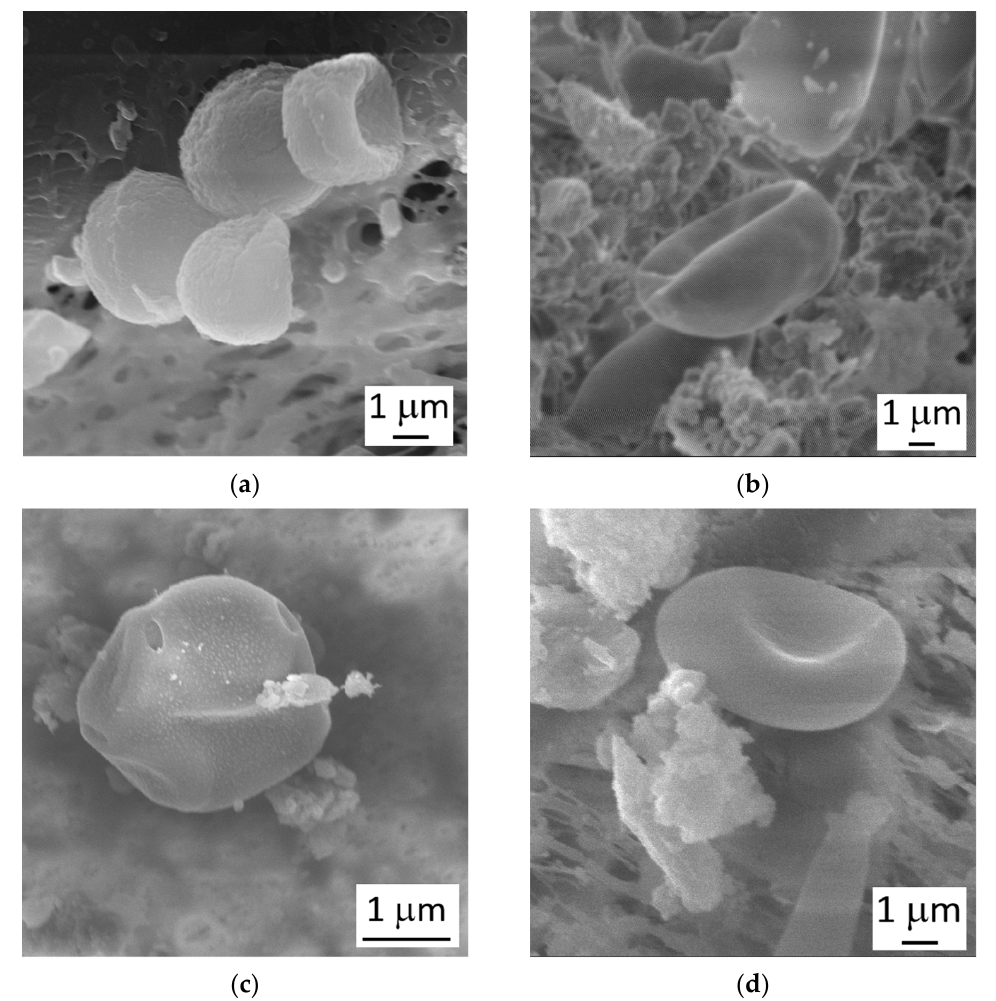
Figure 3. SEM images of various forms of pollen grains found in aerosol samples in Moscow in different years: ( a )— 20 June 2019; ( b )— 23 October 2020; ( c )— 12 April 2021; ( d )— 3 October 2022.